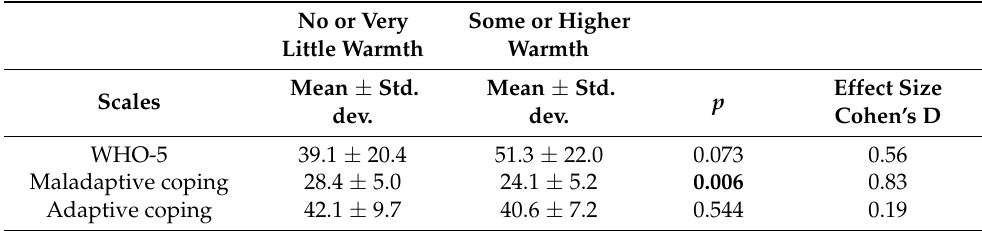
Table 5. World Health Organization Well-Being Index (WHO-5) and Brief COPE based on the level of relatives’ warmth (N = 48). No or Very Some or Higher Little Warmth Mean ± Scales